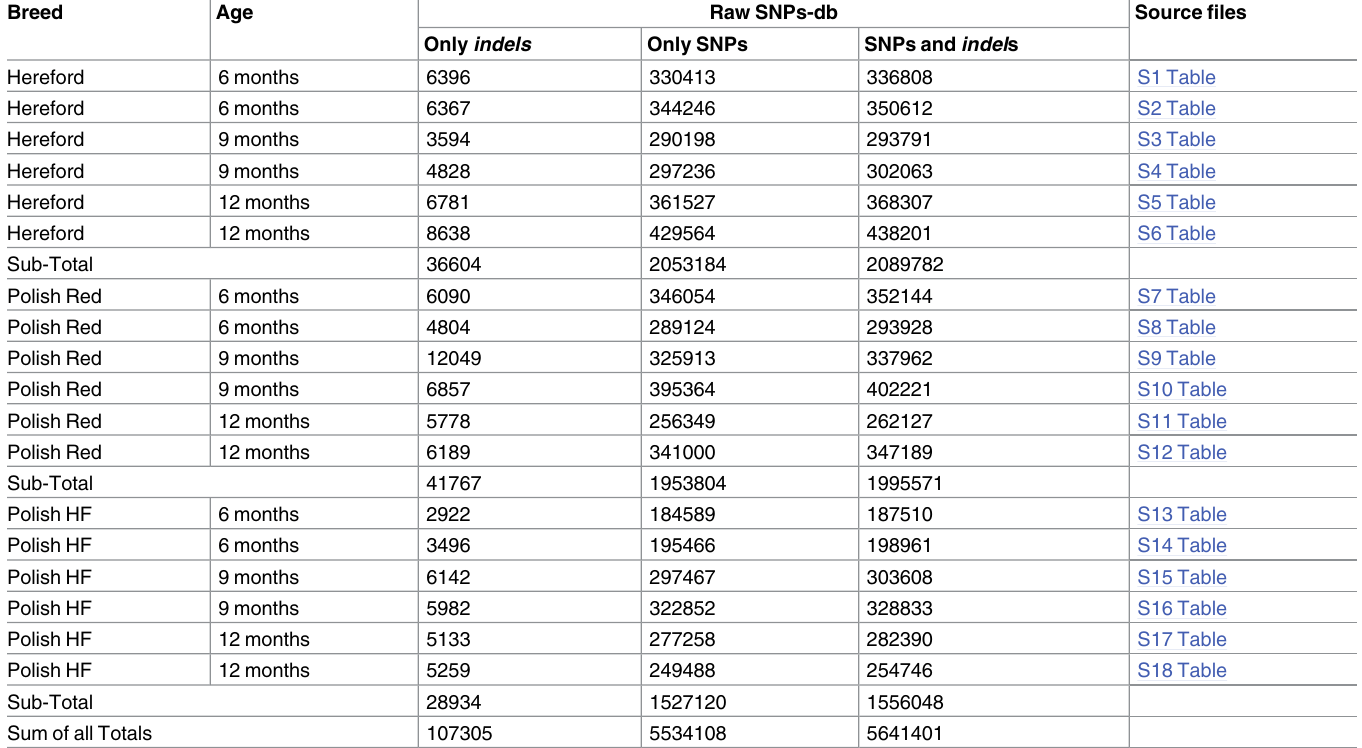
Table 5. Construction of breed-specific raw SNP-db of bovine liver